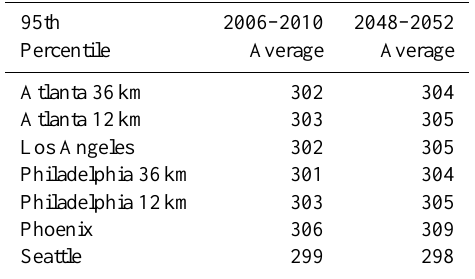
Fig. 2. Predicted average yearly and seasonal 2m atmospheric temperature change (future minus historic) for (a) the 36km × 36km resolution modeling domain, (b) the 12km × 12km resolution sub-domain over the Northeast and (c) the 12km × 12km resolution sub-domain over Figure 2: Predicted average yearly and seasonal 2-m atmospheric temperature change (future 606 the Southeast. minus historic) for (a) the 36x36 km resolution modeling domain, (b) the 12x12 km 607 resolution sub-domain over Northeast and (c) the 12x12 km resolution sub-domain over 608 Southeast. 609 Table 3. The average present (2006–2009) and future (2048–2052) upper 95th percentile in daily maximum temperatures for Atlanta, Los Angeles, Philadelphia, Phoenix and